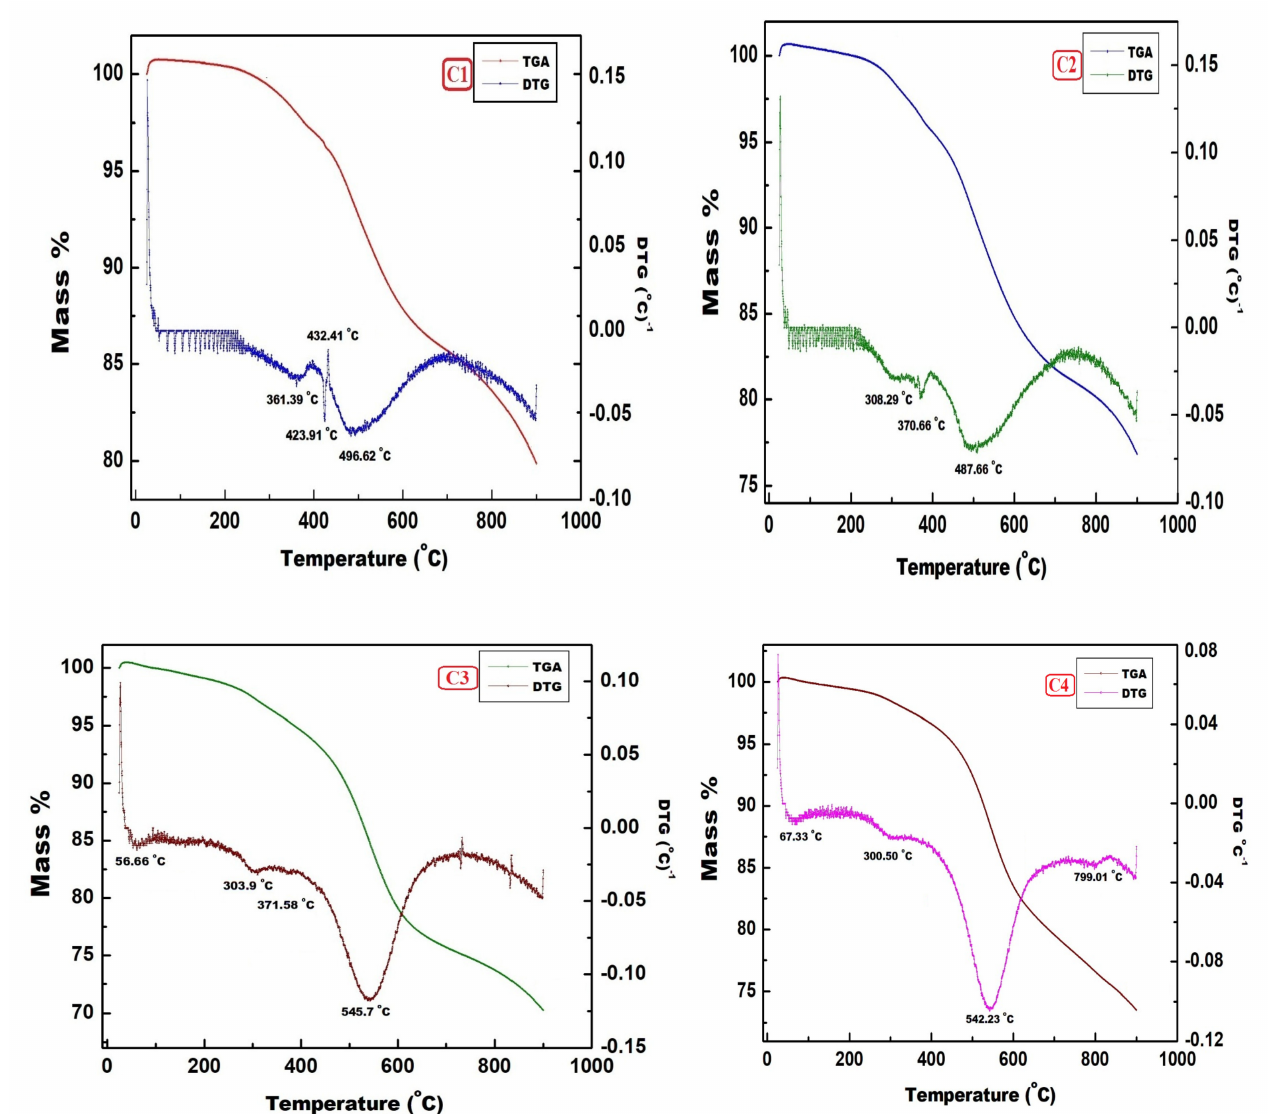
Figure 2. TG-DTG patterns of the C1 , C2 , C3 , and C4